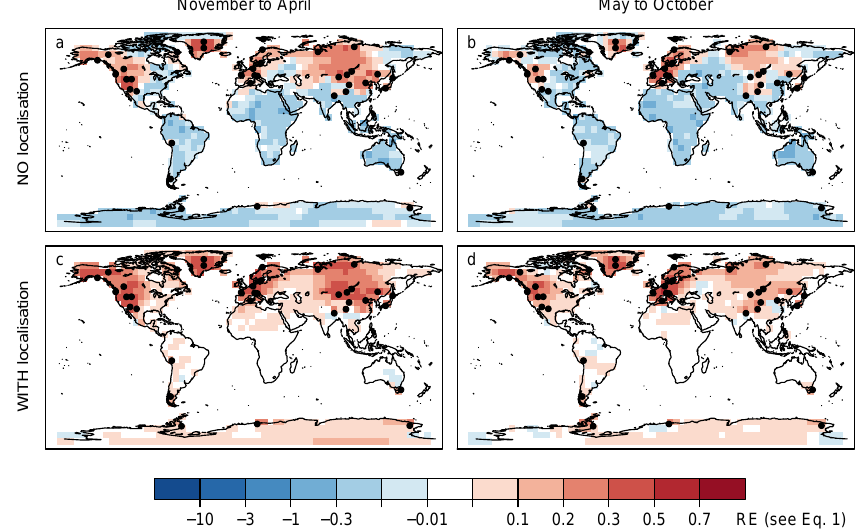
Fig. 3. Mean square error skill score (RE) for near-surface temperature of the analysis ensemble mean compared to the unconstrained ensemble mean without ( a and b ) and with localisation ( c and d ). Results for boreal winter (November to April, a and c ) and for boreal summer (May to October, b and d ). Black dots indicate locations at which pseudo-proxies are assimilated.